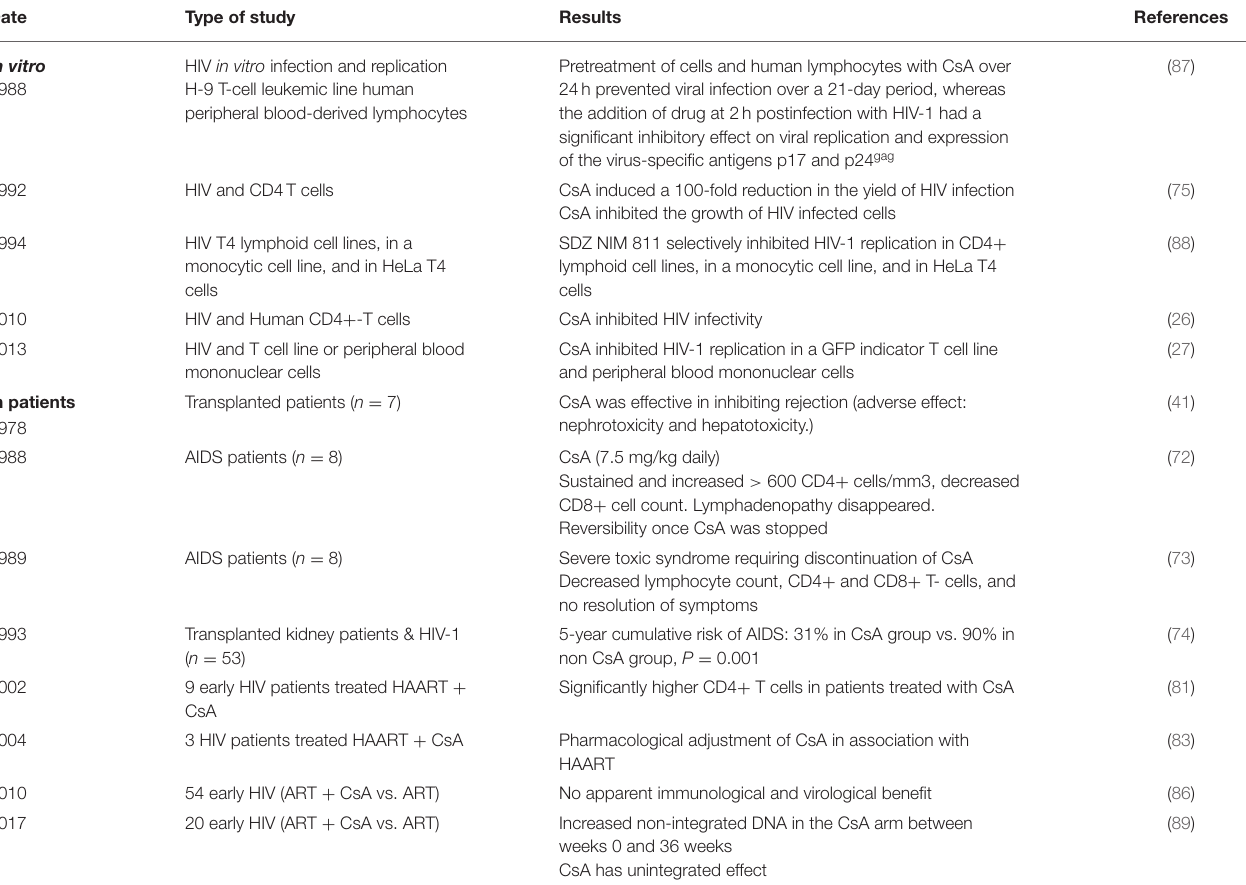
TABLE 2 | In vitro effect of CsA on HIV replication and on disease progression in HIV-infected